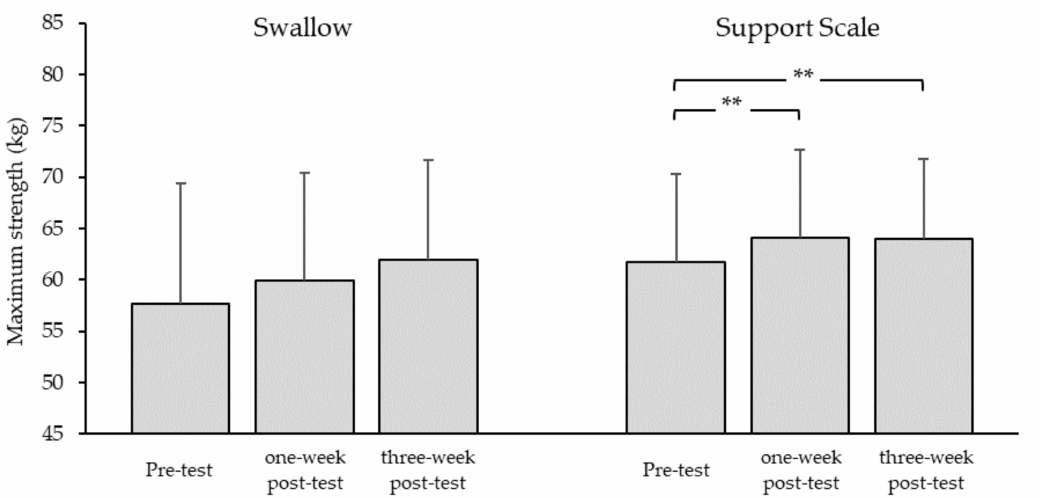
Figure 5. Maximum strength. Mean values and standard deviations for maximal strength (body mass—counterweight or body mass + additional weight) for the swallow and support scale elements when held for 5 s on rings ( n = 8). Pre-test = before training; one-week post-test and three-week post-test = one and three weeks after the four-week eccentric–isokinetic training intervention, respectively; ** significant change: p < 0.01.